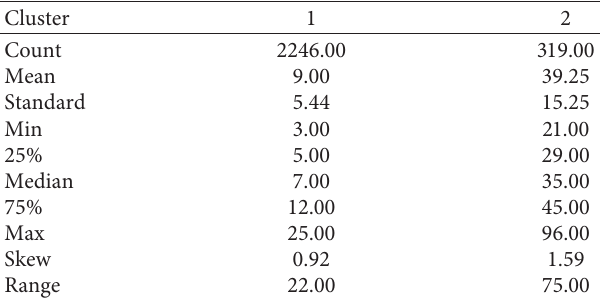
Figure 2: Scatter plots of data. (a) Scatter plot of the original dataset. (b) Scatter plot of the clustered dataset. Table 3: Statistical characteristics of clearance